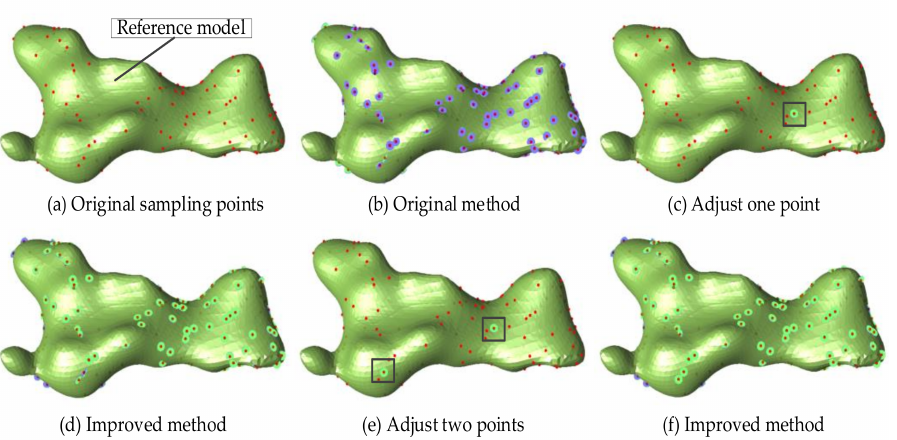
Figure 8. Normal estimation results of the first data set. ( a , b ) show the original sampling points and the normal estimation result obtained by the original method. ( c , d ) show the normal estimation result obtained after adjusting the normal of only one point. ( e , f ) show the normal estimation result obtained after adjusting the normals of two